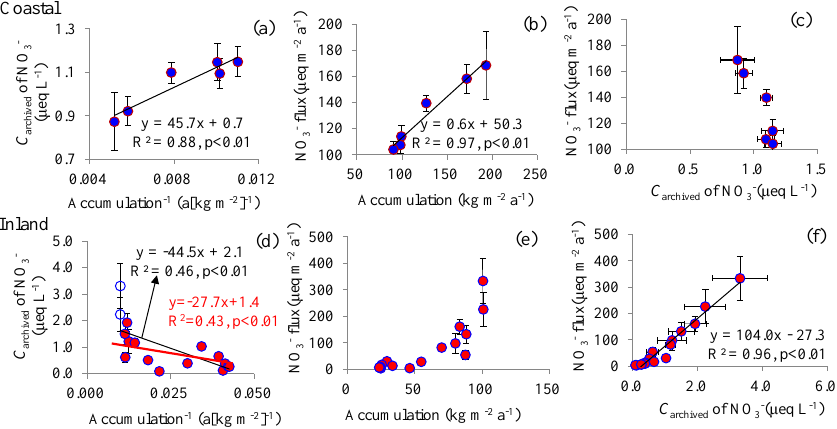
Figure 5. The relationships amongst snow accumulation rate, the archived concentration ( C archived ) , and flux of NO − in coastal ( a , b and c ) 3 and inland ( d , e and f ) Antarctica. In panel (d) , the linear fit in black line ( y = − 44 . 5 x + 2 . 1) includes the full data set, while the linear equation in red ( y = − 27 . 7 x + 1 . 5) was obtained by excluding two cases (open circles) with snow accumulation rate larger than 100kgm − 2 a − 1 (see the main text). The flux values are the product of C archived of NO − and snow accumulation rate, namely the archived flux. Least-squares 3 regressions are noted with solid lines and are significant at p< 0 . 01. Error bars represent 1 standard deviation (1 σ)